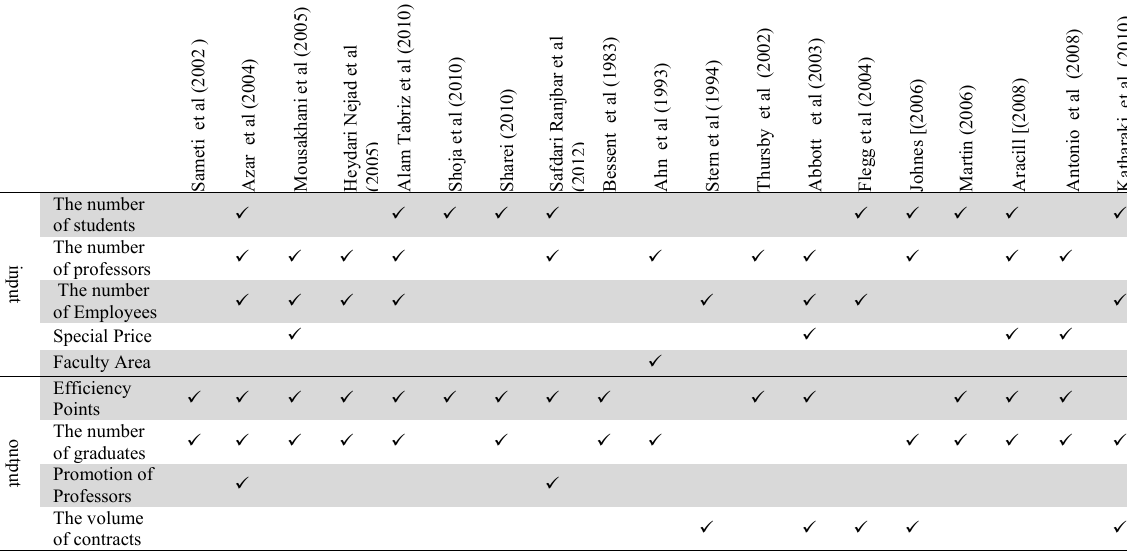
Indicators input and output based on literature